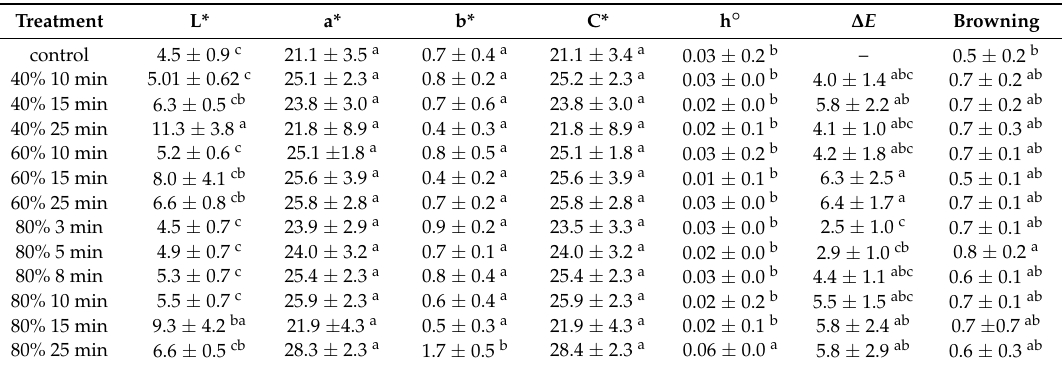
Table 1. Color parameters and browning index of purple cactus pear juice treated at different ultrasound